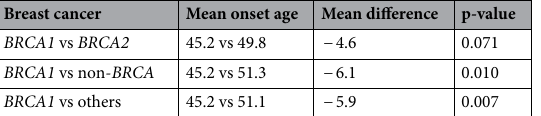
Table 5. Significant and trending differences in the mean onset of breast cancer.